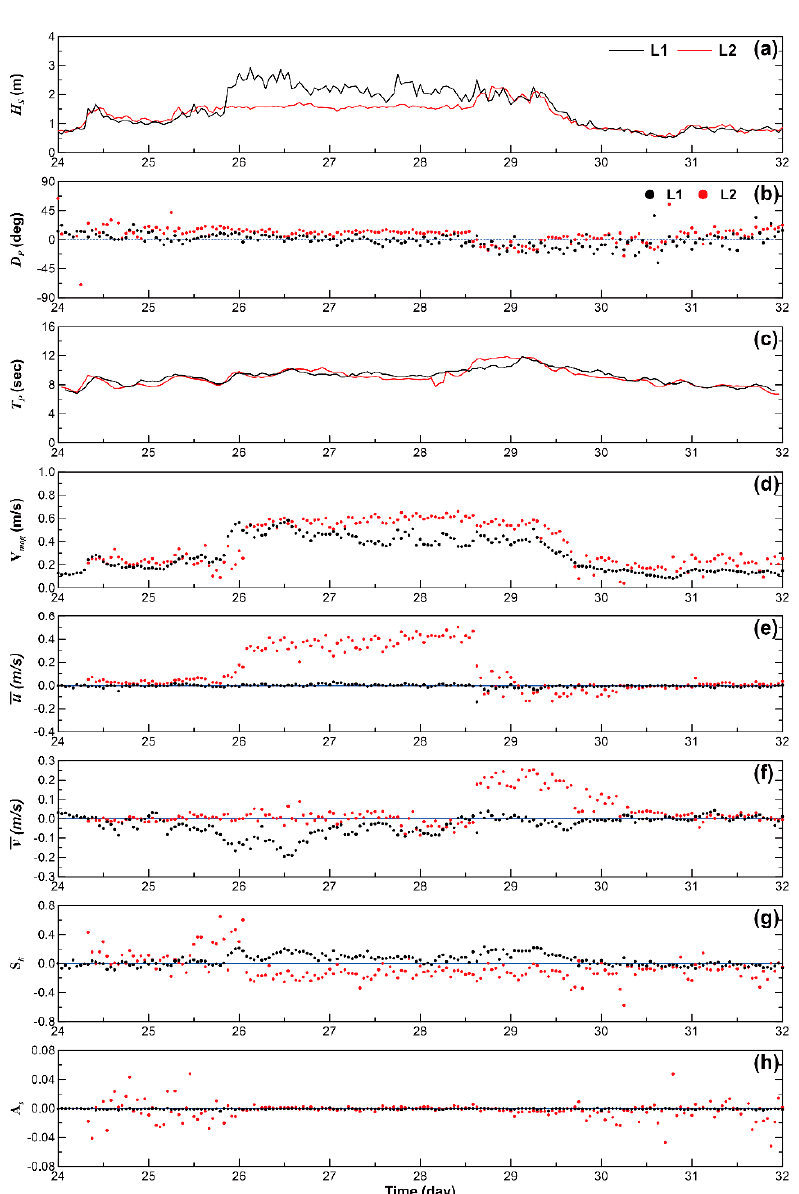
Figure 5. Wave and hydrodynamic parameters from January 7 to 21, 2017 of Exp#1. ( a ) H s : significant wave height, ( b ) D p : peak wave direction, ( c ) T p : peak wave period, ( d ) V mag : velocity magnitude, ( e ) u : cross-shore velocity ( + onshore), ( f ) v : longshore velocity ( + NW, left in the figure), ( g ) S k : wave skewness, ( h ) A s : wave asymmetry.